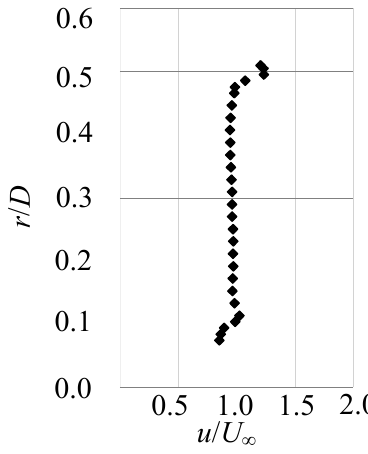
Figure 15. Distribution of the x -component of the wind velocity, u , at x = 0.0588 D for the compact-type Wind-Lens turbine as measured in a wind tunnel experiment [17].